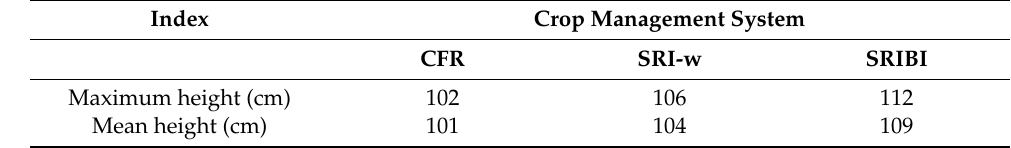
Table 4. A comparison of plant height parameters observed for the three different treatments (2020).